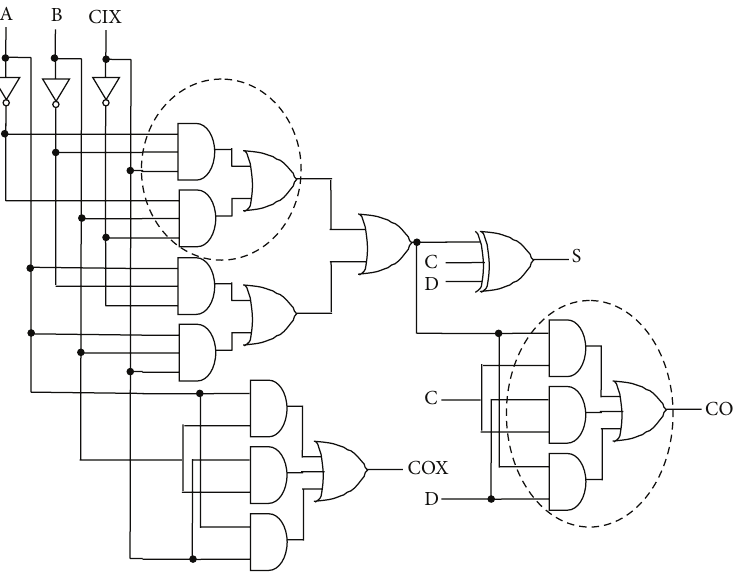
Figure 3: Proposed compressor architecture. Table 1: Existing and proposed compressor architecture